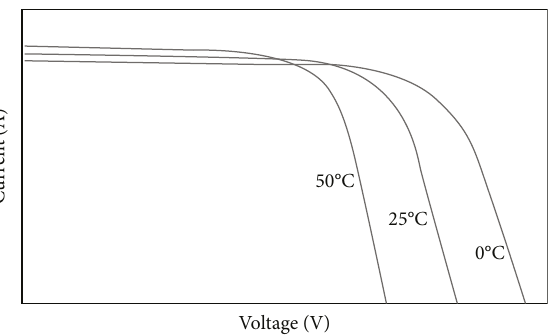
Figure 1: The e ff ect of solar radiation on PV cells [8]. Figure